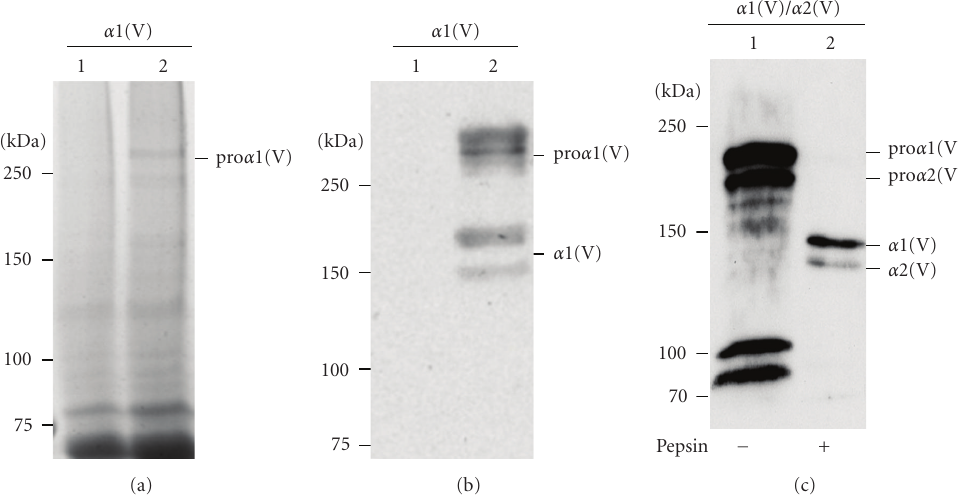
Figure 1: Expression of α 1(V) without the native signal sequence and the C-propeptide (a, b) and of α 1(V)/ α 2(V) chains (c) in P. pastoris . (a) 5% SDS-PAGE analysis under reducing conditions of the soluble fraction of acidic extraction from untransformed yeast cells (lane 1) and from yeast cells transformed with the construct pPICZ α -C5A1N (lane 2). (b) Western blot analysis of the same samples as in panel (a) probed with monoclonal pan-collagen antibody 95D1A. (c) Western blot analysis of the soluble fraction of neutral extraction of yeast cells transformed with α 1(V) and α 2(V) chains and induced with 0.5% methanol induction. Samples were incubated without (lane 1) or with (lane 2) pepsin before analysis. Left, molecular mass standards expressed in